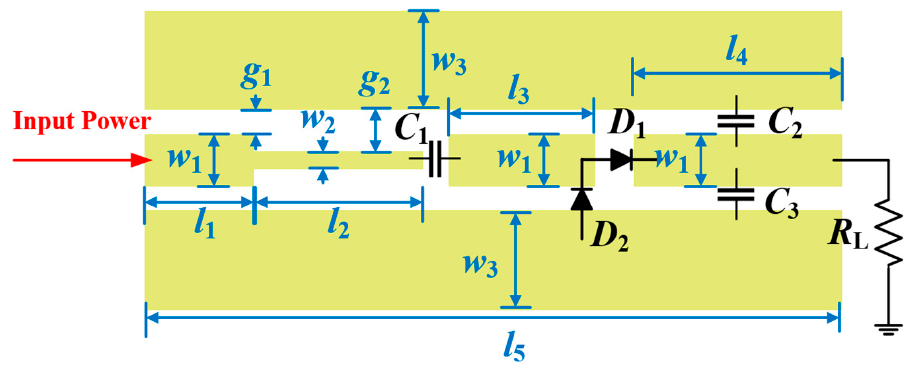
Figure 5. Structure of the proposed rectifier.